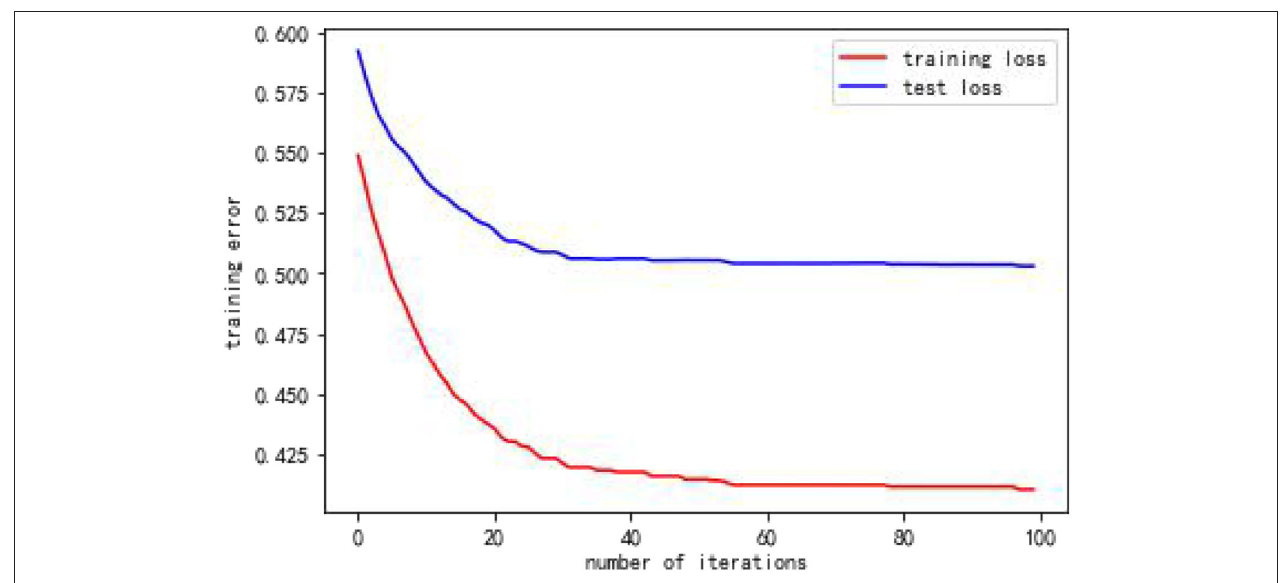
FIGURE 2 | Error variation of XGBoost model over 100